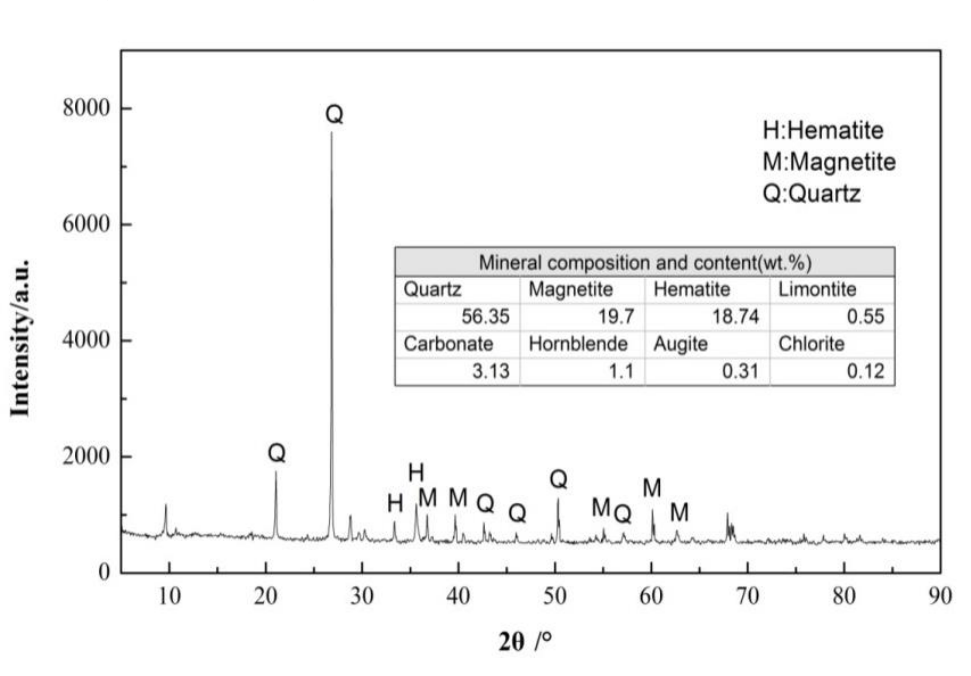
Table 1. The chemical multi-element analysis of the iron ore sample.